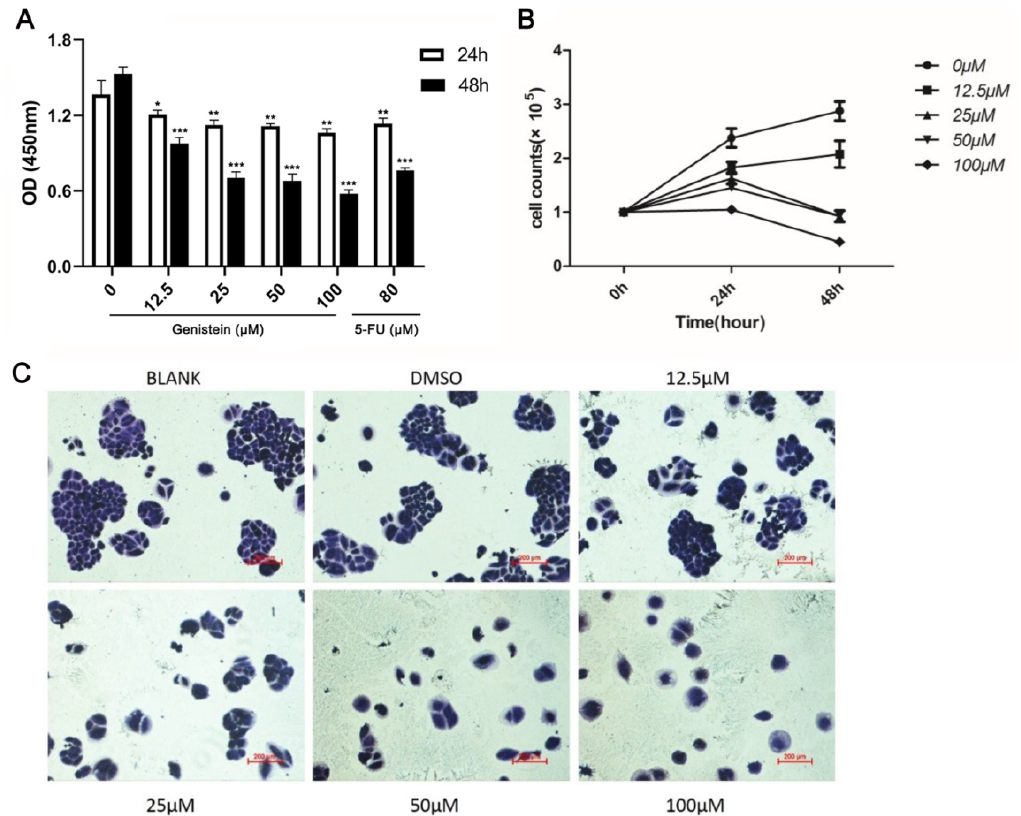
Figure 6. ( A ). Effects of genistein treatment on the proliferation of HeLa cells for 24 − 48 h were detected by CCK − 8 assay. ( B ). Effects of genistein treatment on cell growth were counted by hemocytometer after 24 − 48 h. ( C ). Representative images of HeLa cell colony formation after genistein treatment (0 − 100 μ M). The data shown are the average of three replicates; the experiments were performed three times independently. *** p < 0.001, ** p < 0.01, * p < 0.05 compared with solvent control. Scale bar: 200 µ